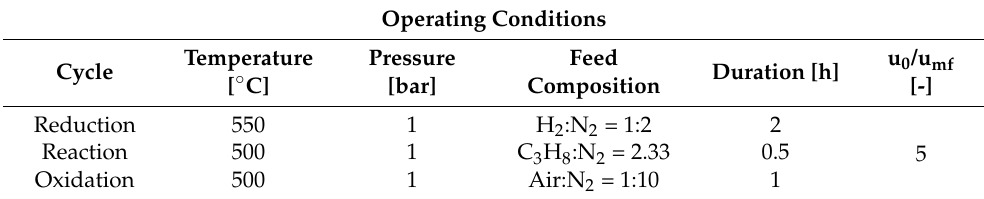
Table A5. Experimental conditions during the stabilization cycles.